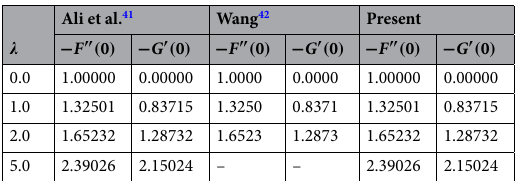
(cid:31) at ζ 1 when ignore other =